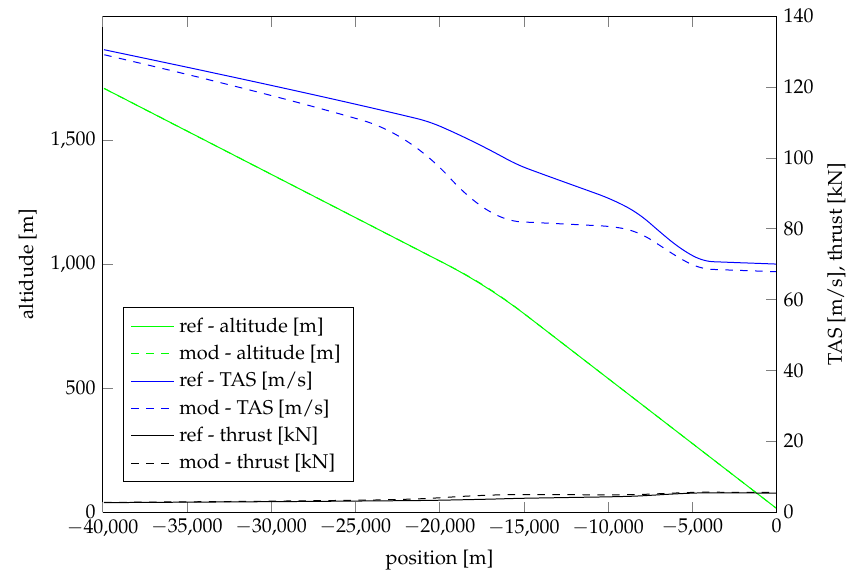
Figure A1. Flight paths (altitude, true airspeed (TAS), thrust) of reference configuration (V-R) and “gamechanger” during approach. The airport is located at position = 0m. From [23] with permission.